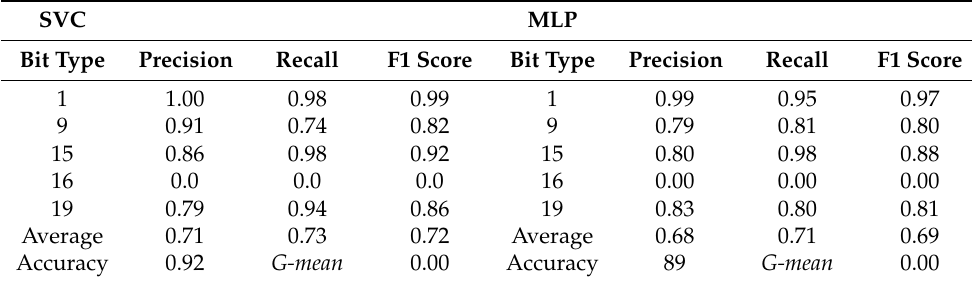
Table 9. The screening of 17.5” bits through MLP and SVC